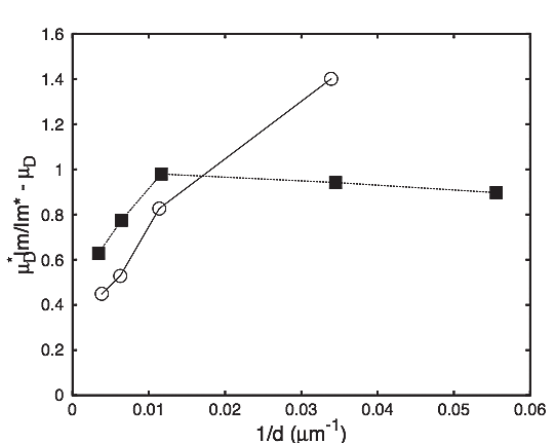
Fig. 8 Results of Fig. 7 -right versus the inverse of the mean diameter. Squares: calcites, circles: glass beads.